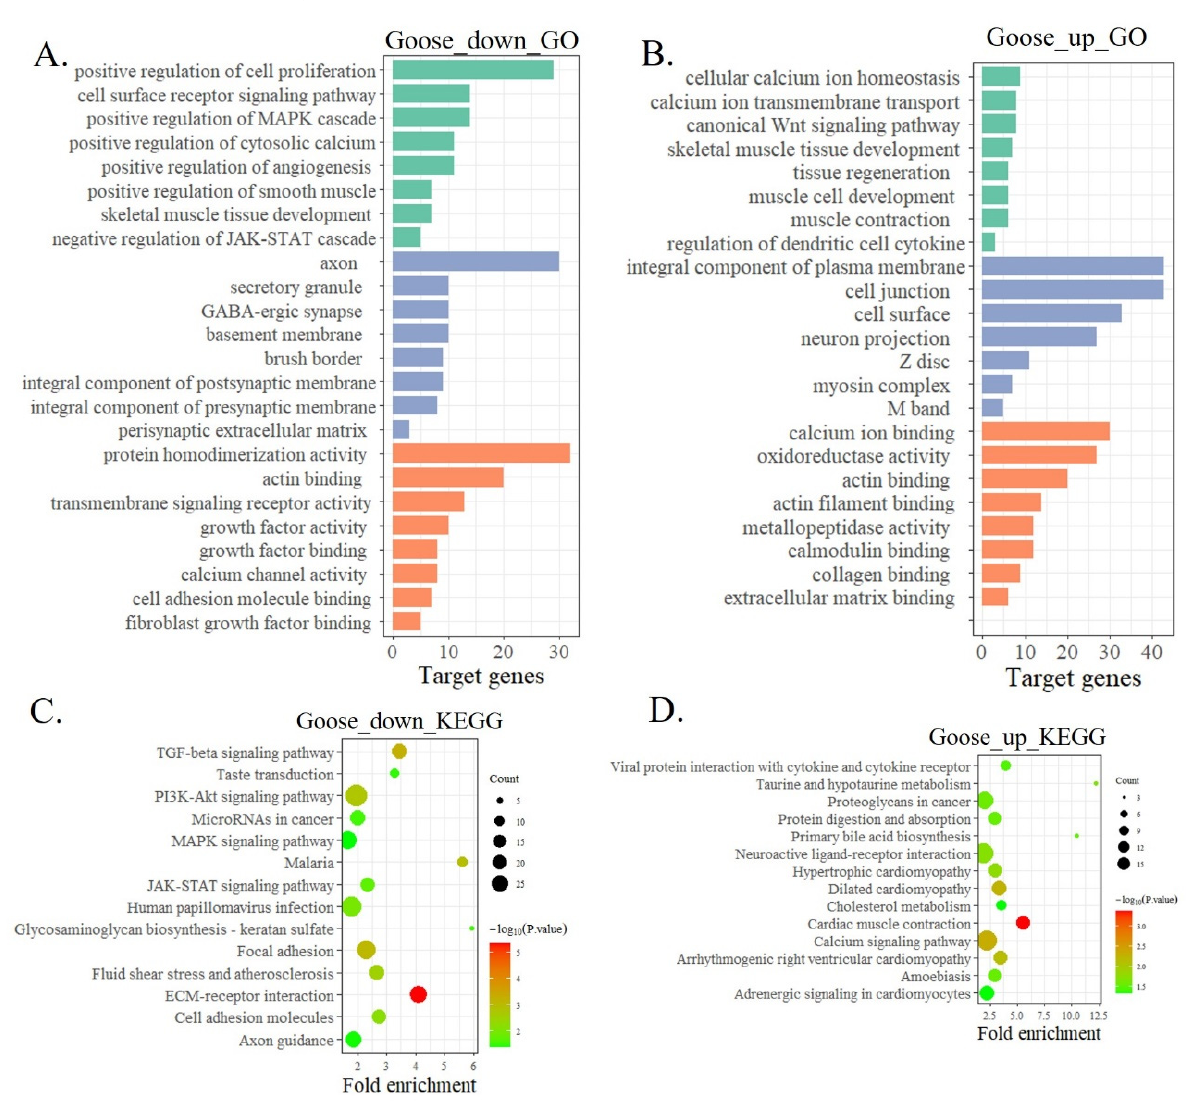
Figure 2. A functional analysis of DEGs between Shitou goose myoblasts and myotubes. ( A ) Gene Ontology enrichment of down-regulated DEGs; ( B ) gene ontology enrichment of up-regulated DEGs; ( C ) the significantly enriched KEGG pathways of down-regulated DEGs; ( D ) the significantly enriched KEGG pathways of up-regulated